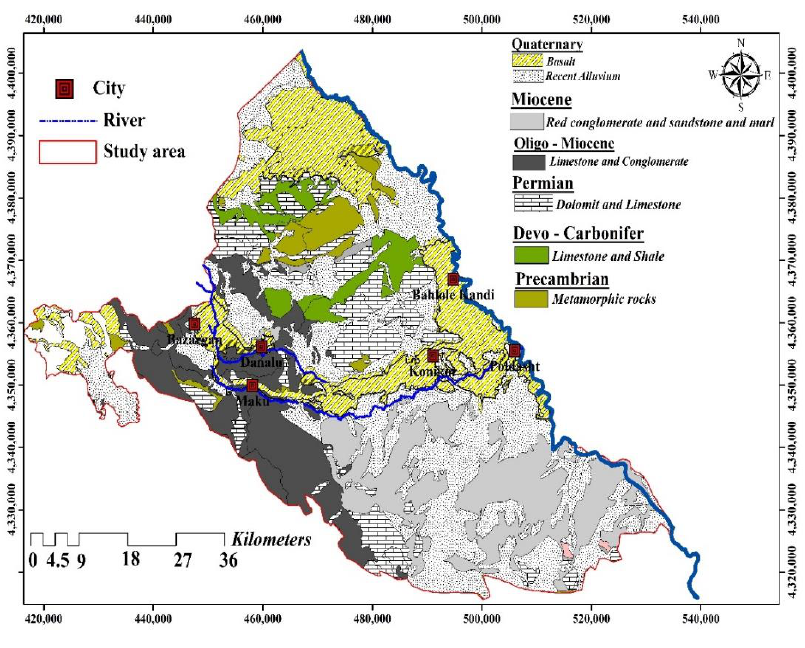
Figure 3. Geological map of the Maku–Bazargan–Poldasht